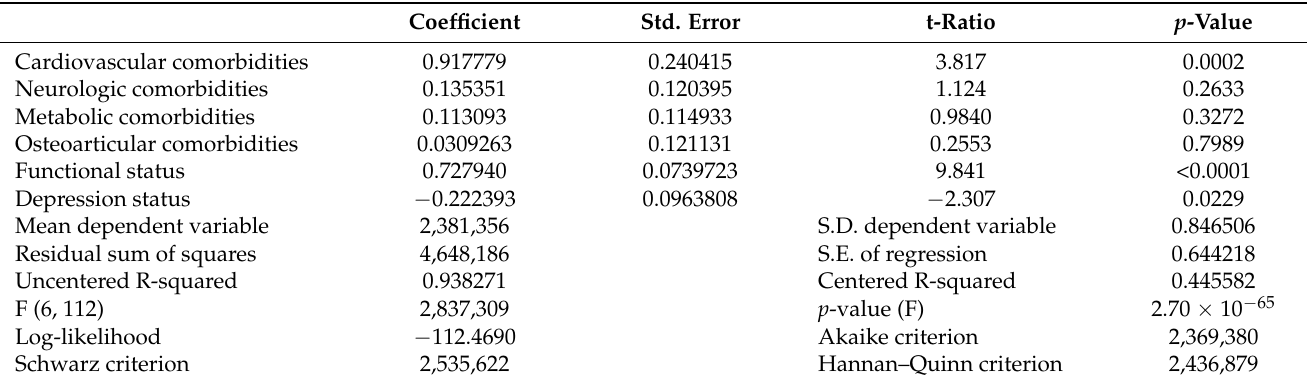
Table 9. Pearson correlation coefficient in the Model ACTIVE GROUP: OLS (Dependent variable: COGNITIVE STATUS) shows a high dependence for some comorbidities (especially cardiovascular) and functional status in dementia patients (S.D. = standard deviation; S.E. = standard error). Coefficient Std. Error t-Ratio p -Value